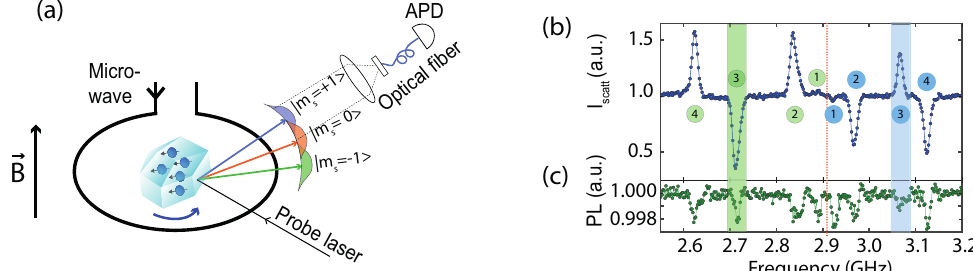
Figure 7. ( a ) Sketch showing a NV-doped diamond in a Paul trap where the probe laser reflection angle from the diamond surface depends on the spin state. ( b ) Mechanically detected magnetic resonance observed by scanning the microwave tone about the NV transitions. ( c ) ODMR in similar experimental conditions. Adapted from